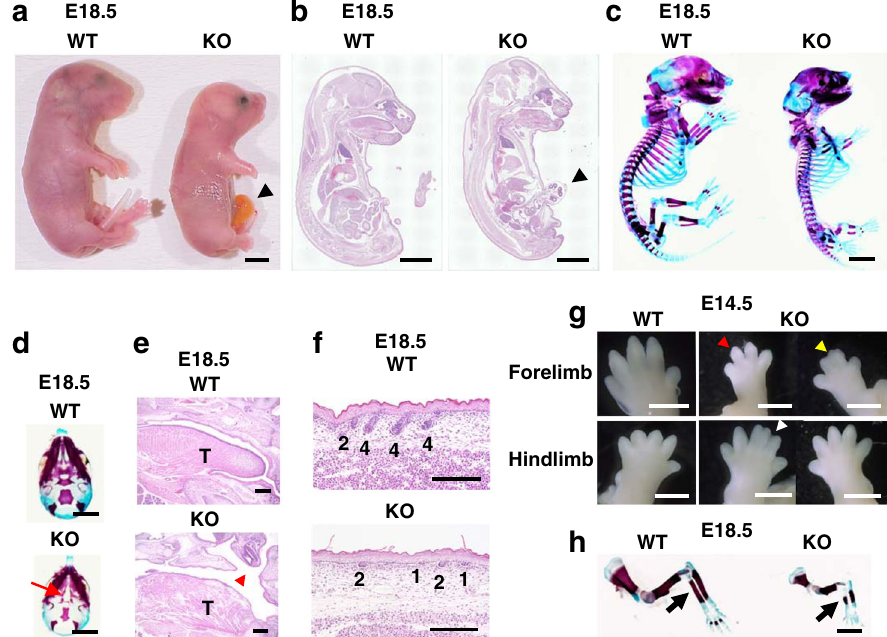
Fig. 1 Loss of Dyrk2 leads to multiple developmental abnormalities. Dyrk2 − / − mice exhibit multiple defects in craniofacial, hair follicle, and radial/limb development. a Lateral views of E18.5 embryos. Arrowhead; omphalocele. b Lateral views of H&E sections in E18.5 embryos. Arrowhead; omphalocele. c Lateral views of skeleton preps in E18.5 embryos. d Palatal shelves in E18.5 embryos. Red arrow; cleft palates. e H&E staining of palate in E18.5 embryos. Red arrowhead; cleft palates. T, tongue. f H&E staining of skin in E18.5 embryos. Numbers denote the stages of hair follicle morphogenesis. g Limb dysmorphology of E14.5 embryos. The red arrowhead; ectrodactyly. The yellow arrowhead; syndactyly. The white arrowhead; syndactyly and polydactyly. h Radial anomalies of E18.5 embryos. Black arrows; radial bones. Scale bar: 3 mm in a – d , h , 400 μ m in e , 200 μ m in f , 1 mm in g